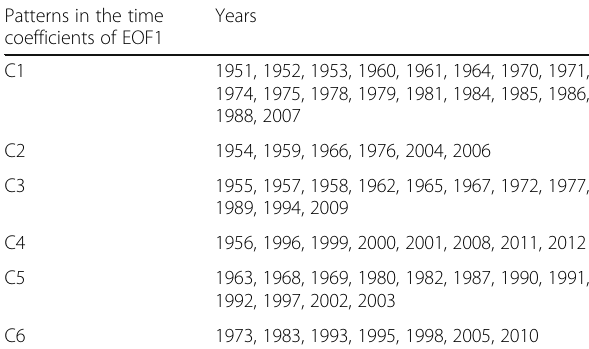
Table 1 Patterns classification in the time coefficients of EOF1 for 1951 – 2012 based on cluster analysis Patterns in the time coefficients of